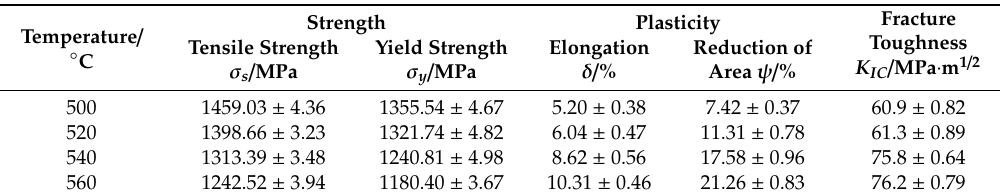
Table 4. Mechanical properties of the alloy after aging for 8 h.